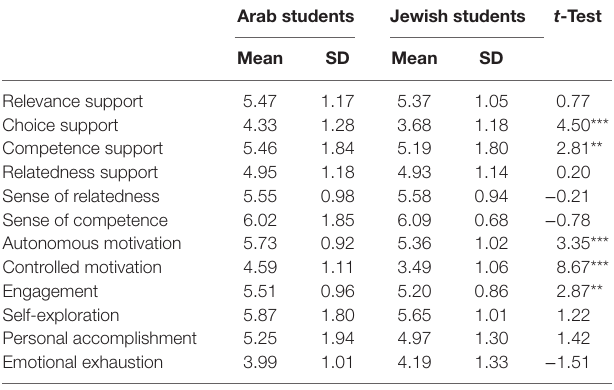
Table 3 | Mean-level comparisons between cultural groups. arab students Jewish students t -Test Mean sD Mean